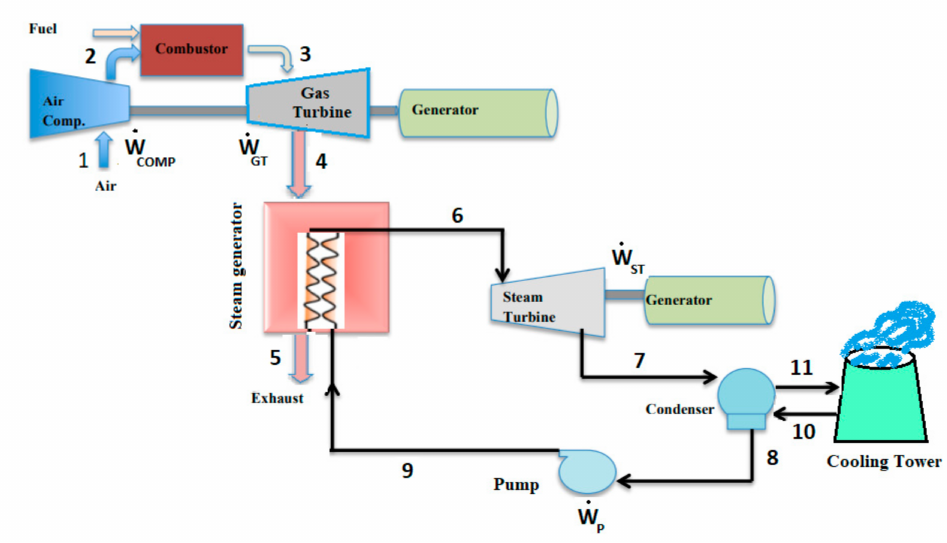
Figure 1. Schematic of the combined simple Brayton and Rankine cycle (Config.